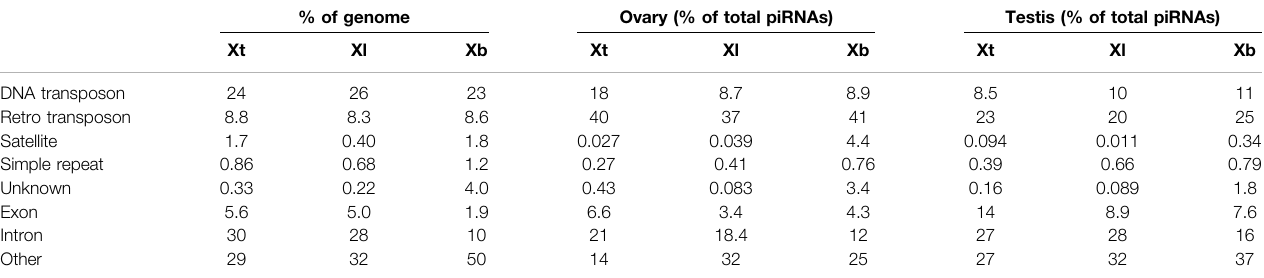
TABLE 1 | Proportion (%) of each DNA or RNA component in genomic DNA or total piRNAs of X. tropicalis ( Xt ), X. laevis ( Xl ), and X. borealis ( Xb ). % of genome Ovary (% of total